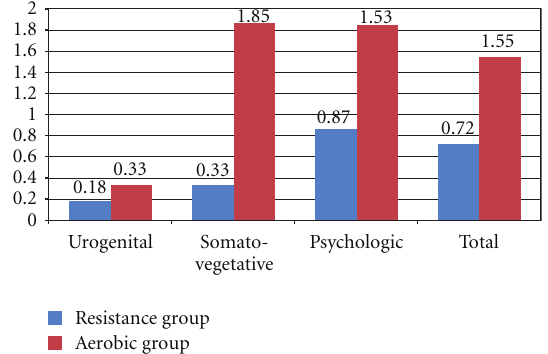
Figure 2: The Influence Quantity calculated for changes in subscales of MRS scale. IQ: Influence